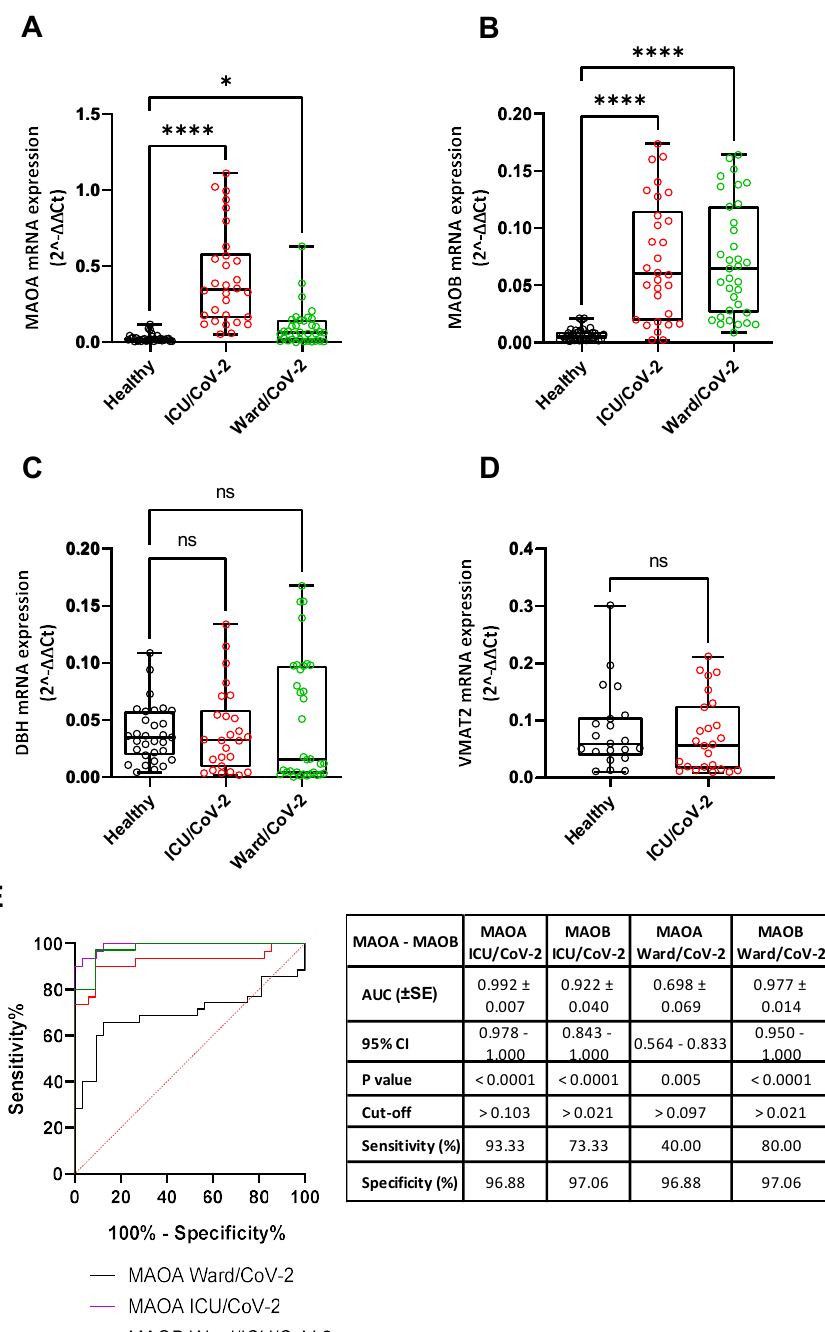
Figure 7. Comparison of the mRNA expression of ( A ) MAOA , ( B ) MAOB , ( C ) DBH and ( D ) VMAT2 in hospitalized SARS-CoV-2 positive (ICU/CoV-2, Ward/CoV-2 groups) and healthy subjects (Healthy). The mRNA expression data are presented as box plots; line in the middle corresponds for the median value; box edges refer to the 25th and 75th centiles; whiskers, range of values. p -values were determined by the Kruskal–Wallis non-parametric test. The Dunns’s test was performed for multiple comparisons among the studied patient groups. * p < 0.05, **** p < 0.0001 vs. Healthy, ns: non-significant. The p -value for VMAT-2 expression was evaluated with unpaired t -test. ( E ) ROC curve analysis for the aforementioned-genes expression. AUC, 95% CI, p -values, and cut-off points with their specificity and sensitivity were reported. The red dotted line denotes perfect chance (positive likelihood ratio = sensitivity/(1-specificity)